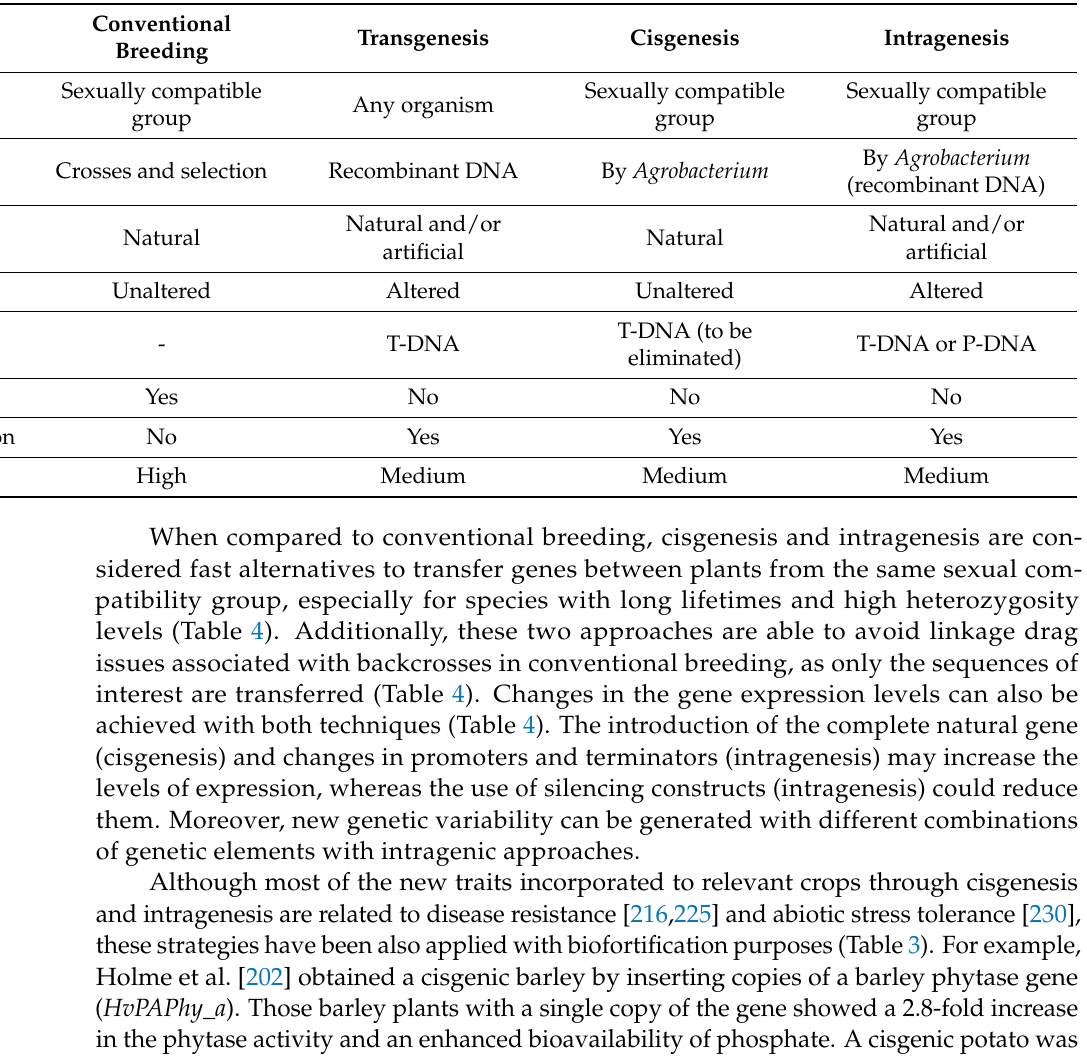
Table 4. Comparison of the main characteristics of conventional breeding, transgenesis, cisgenesis, and